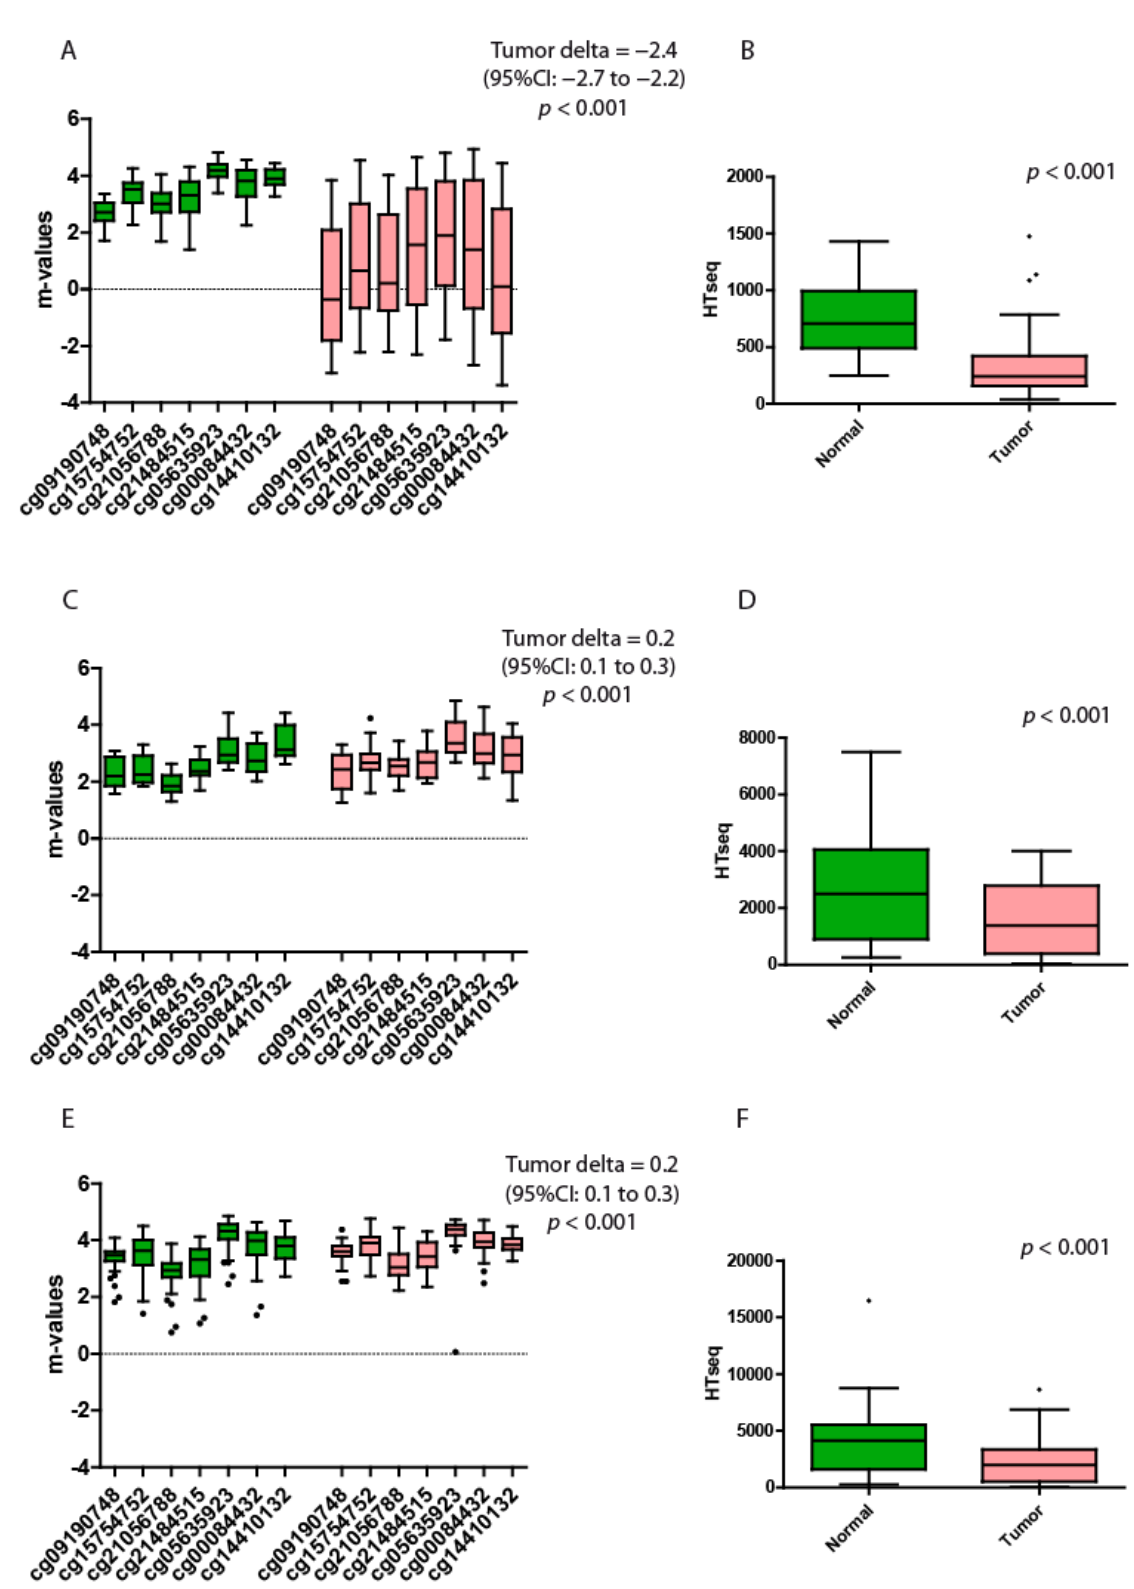
Figure 4. Quantitative methylation and gene expression analysis of hepatocellular, lung and prostate carcinomas. ( A ) Hepatocellular m-values of the 7 probes located at the open sea region of the